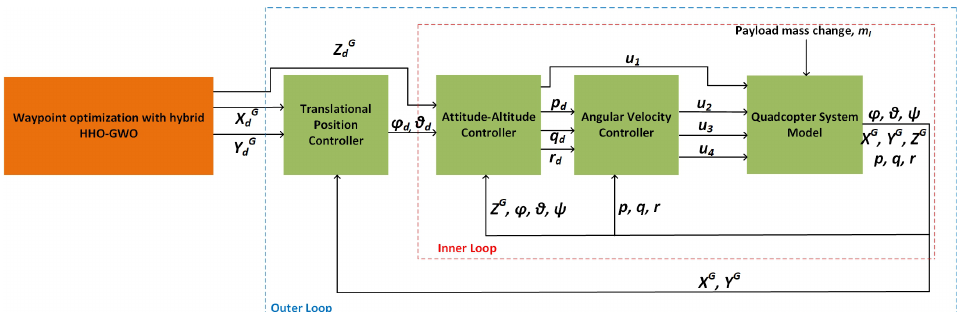
Figure 2. The proposed control strategy of the